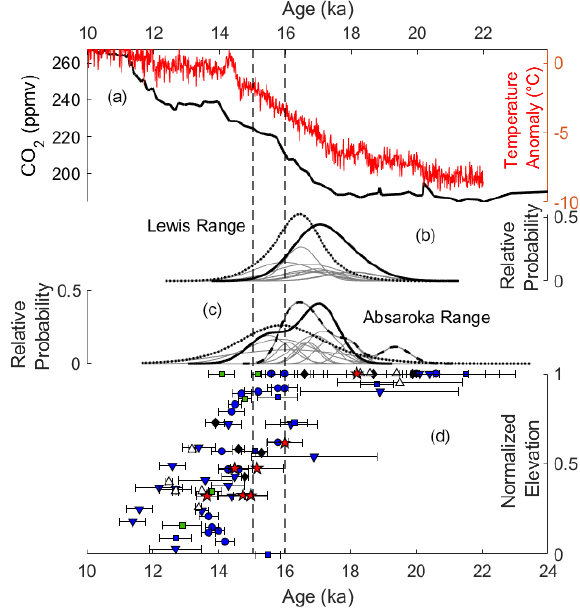
Figure 9. (a) Surface temperature anomalies from TRACE-21ka for western North America (Shakun et al., 2015; red) and Epica– Vostok composite CO 2 concentrations (Petit et al., 1999; Monnin et al., 2001; Pépin et al., 2001). (b) Camel plots of exposure age data from Cut Bank glacier in the Lewis Range: Cut Bank terminal (solid line) and Cut Bank recessional (dotted line). (c) Absaroka Range: South Fork Deep Creek (solid line), Cascade Creek (dotted line), and Pine Creek (dashed line). (d) Normalized glacier elevation (i.e., 1: terminus, 0: headwall) for Pine Creek glacier in the Absaroka Range (red stars), Teton Range, WY (green boxes), Wasatch Range, UT (black diamonds), Uinta Mountains, UT (white triangles), Front Range, CO (blue inverted triangles), Sawatch Range, CO (blue cir- cles), and San Juan Range, CO (blue squares), based on cosmogenic exposure dating. Dashed vertical lines bracket the approximate tim- ing of the separation of the Laurentide and Cordilleran ice sheets in North